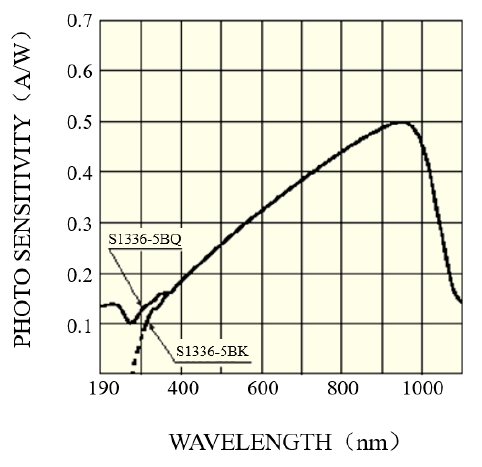
Figure 8. The photosensitivity vs. wavelength dependence of S1336-5BK.